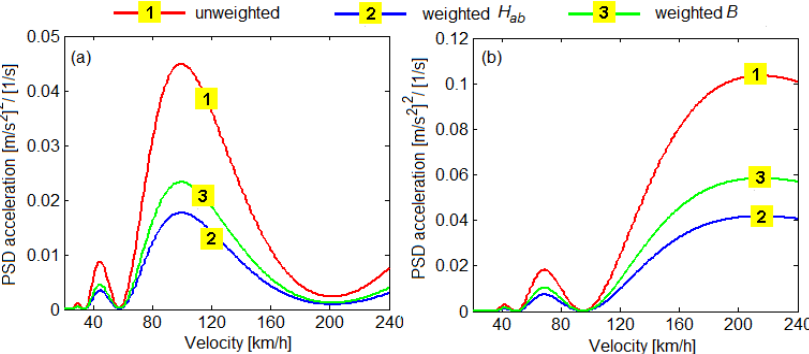
Figure 10. Effect of the frequency weighting upon the carbody dynamic response in the reference point B 1 : ( a ) at the bounce resonance frequency (1.17 Hz); ( b ) at the pitch resonance frequency (1.53 Hz).